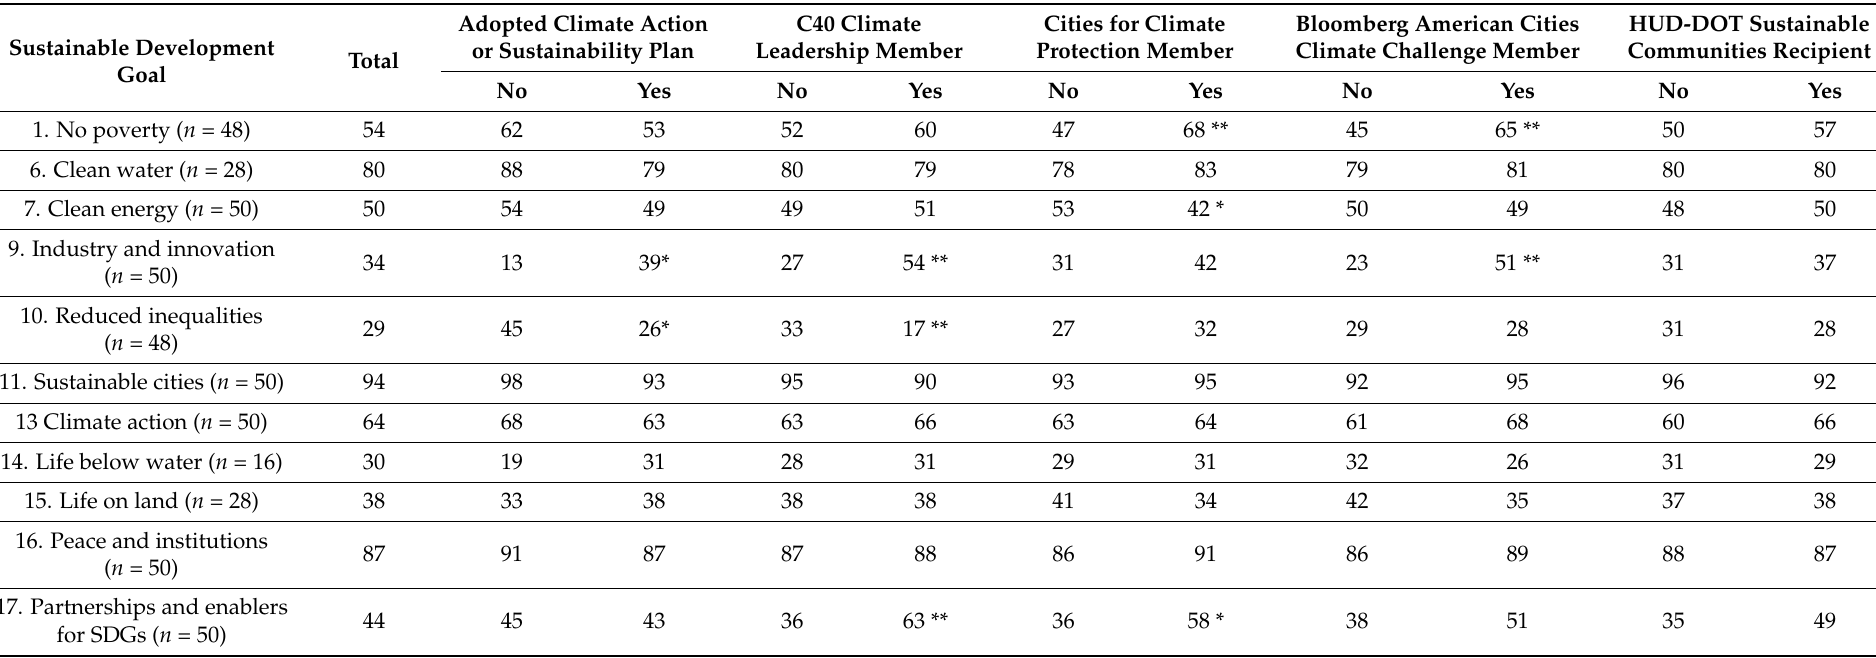
Table 3. Mean Percentage Attainment of SDG Goals by Environmental and Sustainability Action, Sample Cities in Inventory of Collaborative Initiatives. Statistically significant differences between no and yes cities are noted with * ( p < 0.05) and ** ( p < 0.01). Source: Authors calculations from OECD data